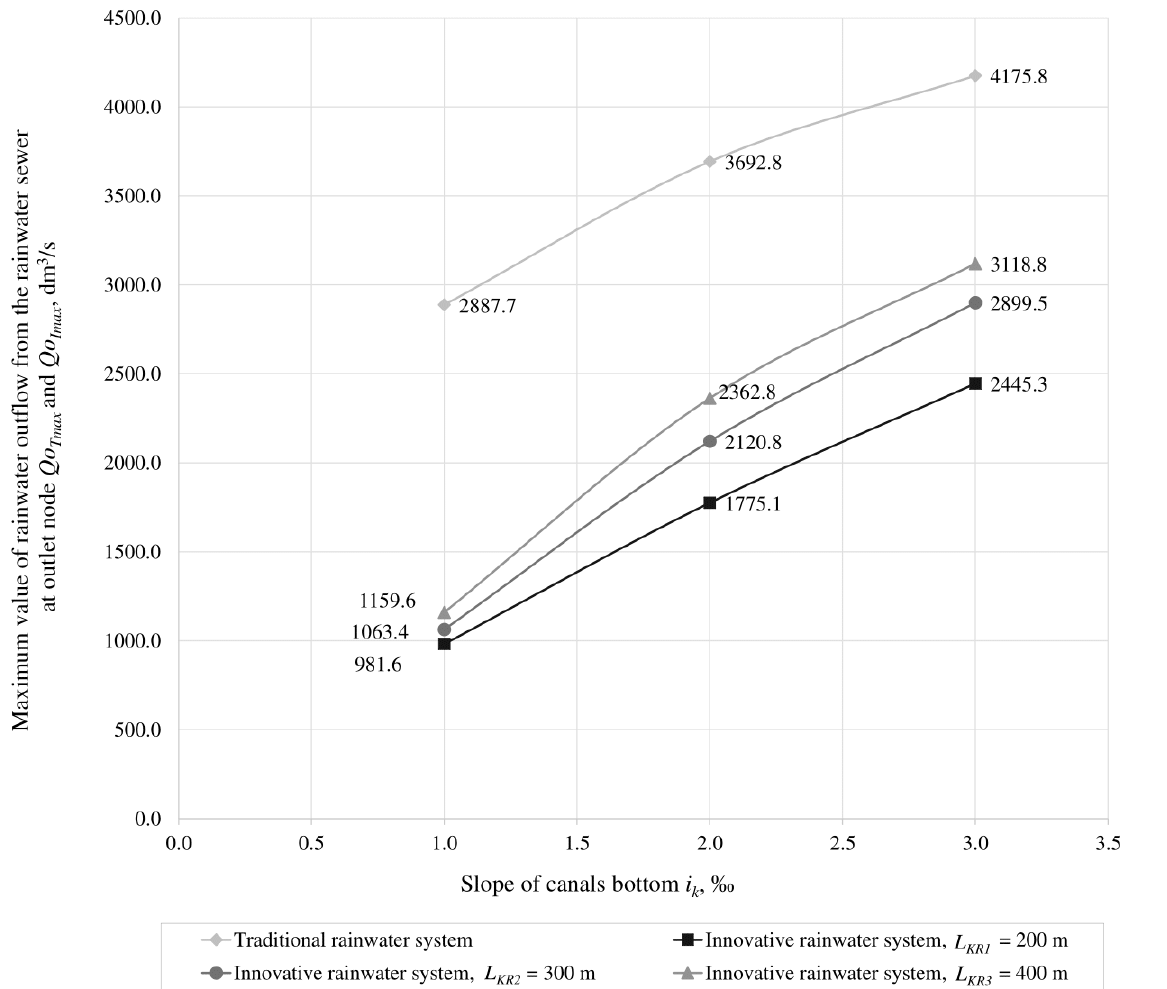
and innovative Tmax